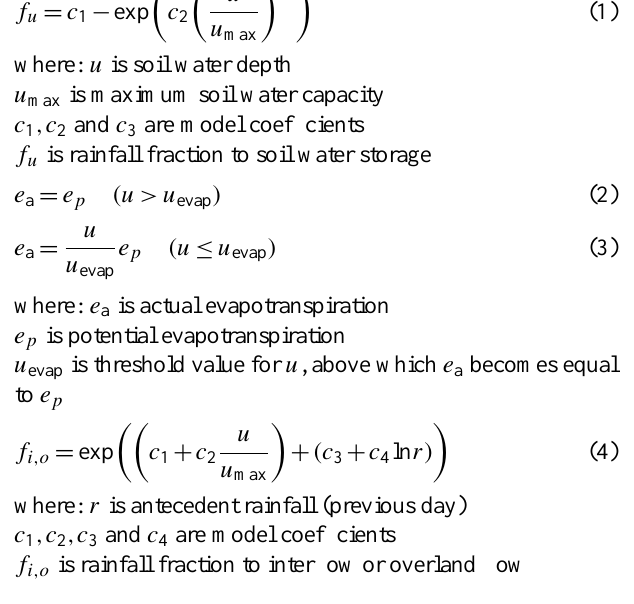
Fig. 2. Steps in the VHM model structure identification and cali- bration procedure (adapted from Willems,